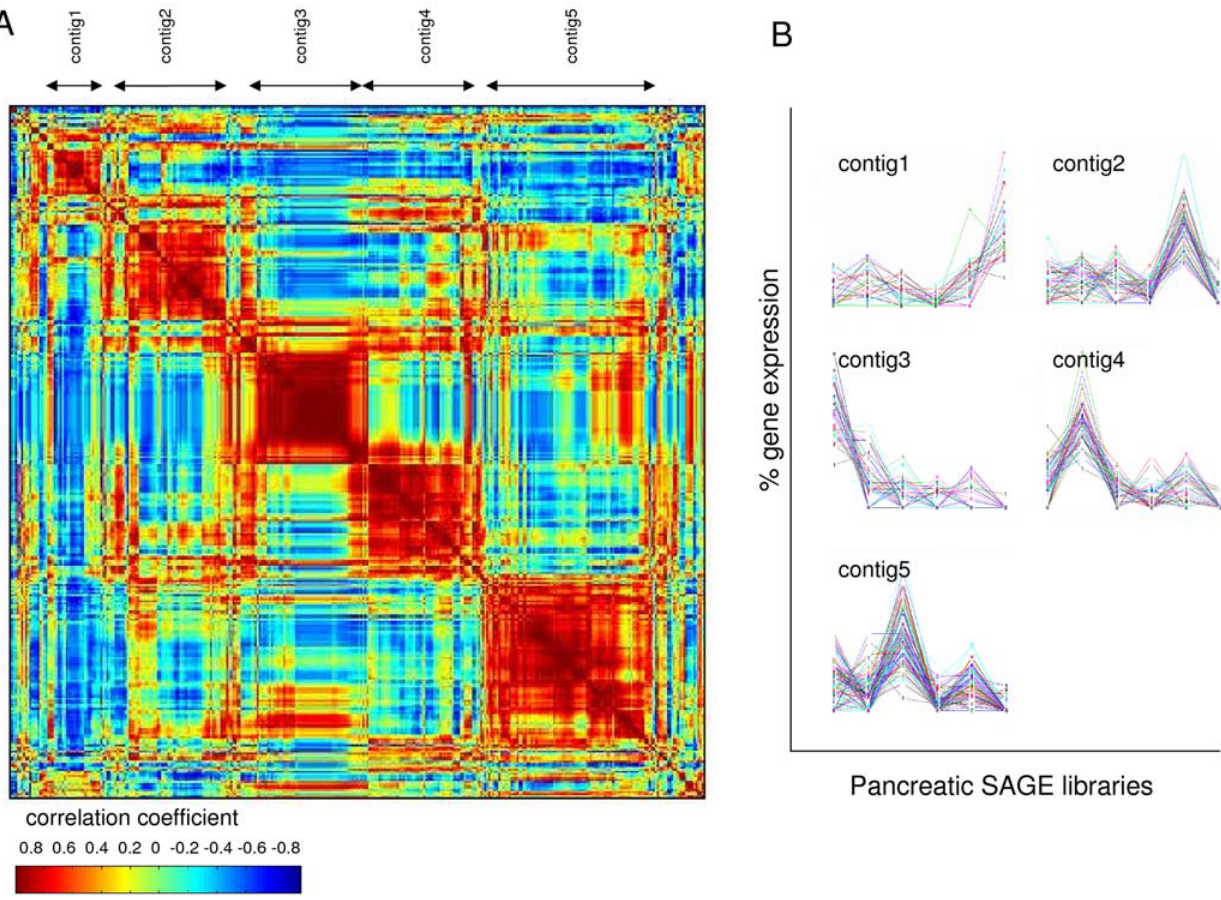
Figure 4. Seriation of transcription factors expressed in Mouse Atlas pancreatic libraries. SAGE data for transcription factors expressed in the pancreatic libraries from the Mouse Atlas project were subjected to seriation analysis as described in the text. The reordered correlation matrix containing correlation coefficients for each tag pair computed to measure the similarity of their pancreatic expression profiles is color-coded red to blue to represent decreasing correlation values. (A). 5 contigs recognizable as red squares along the diagonal are evident. (B). Expression profiles of transcription factors in contigs in (A). The relative expression levels from 0% to 100% are plotted on the y-axis for each contig while the pancreatic libraries derived from stages TS17, TS19, TS20, TS21, TS22, and P70 are on the x-axis.